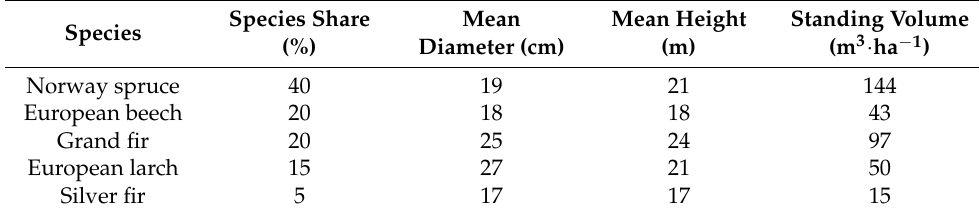
Table 1. Basic dendrometric